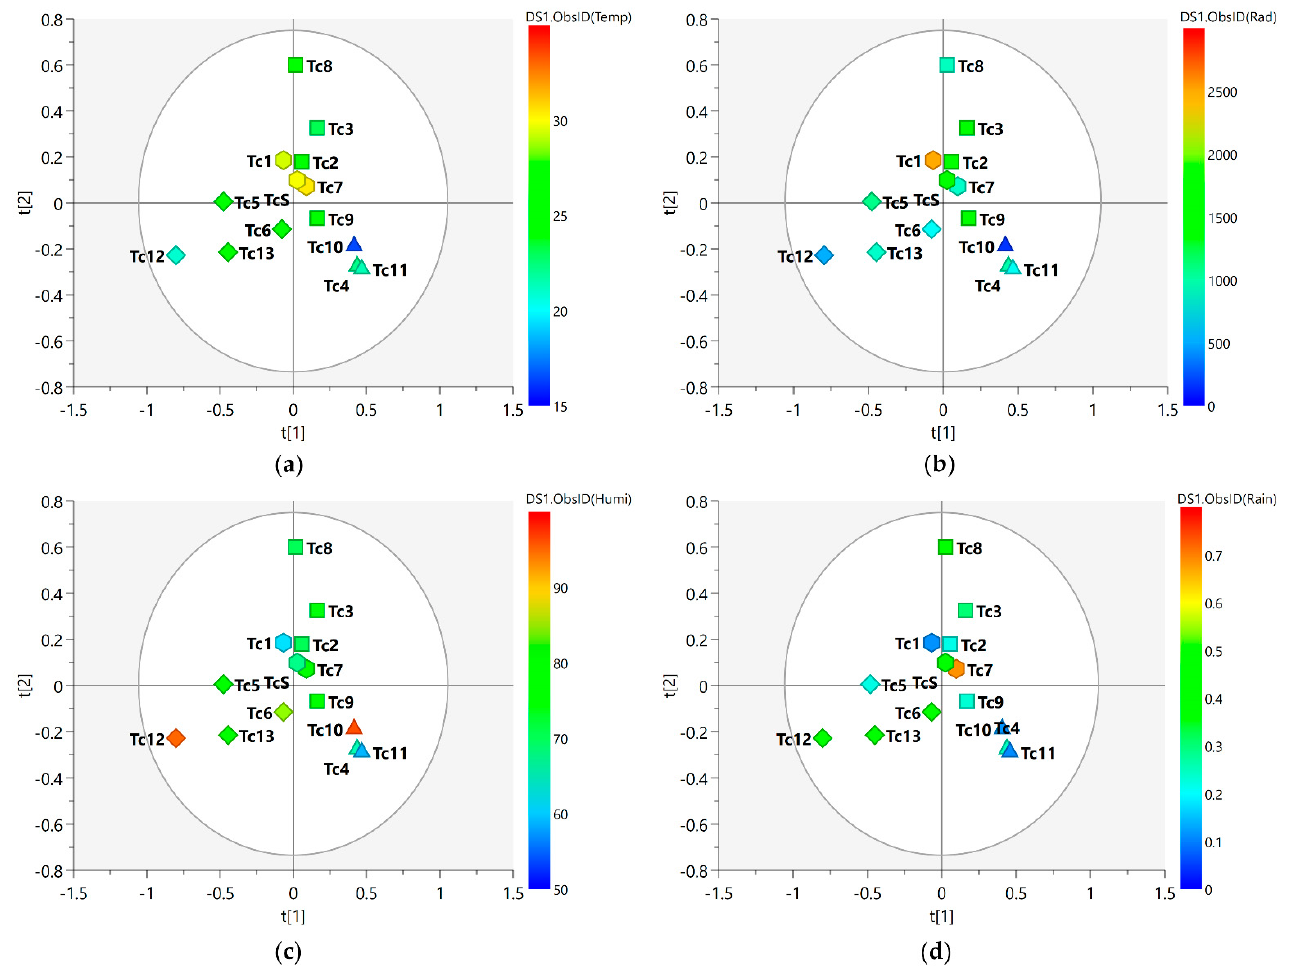
Figure 3. PLS-DA score scatter plots of the MS-NMR fused data of T. catappa seasonal harvests and the correlation with the environmental factors. Samples are categorized according to the values of observations for environmental factors: ( a ) Temp = temperature (°C); ( b ) Rad = Solar radiation (kJ/m 2 ); ( c ) Humi = relative humidity (%); ( d ) Rain = rainfall (mm). Season samples are represented by hexagon—Summer (Tc1, Tc7, and TcS), square—Autumn (Tc2, Tc3, Tc8, and Tc9), triangle— Winter (Tc4, Tc10, and Tc11), and diamond—Spring (Tc5, Tc6, Tc12, and Tc13). Blue indicates minimum values; red indicates maximum values.